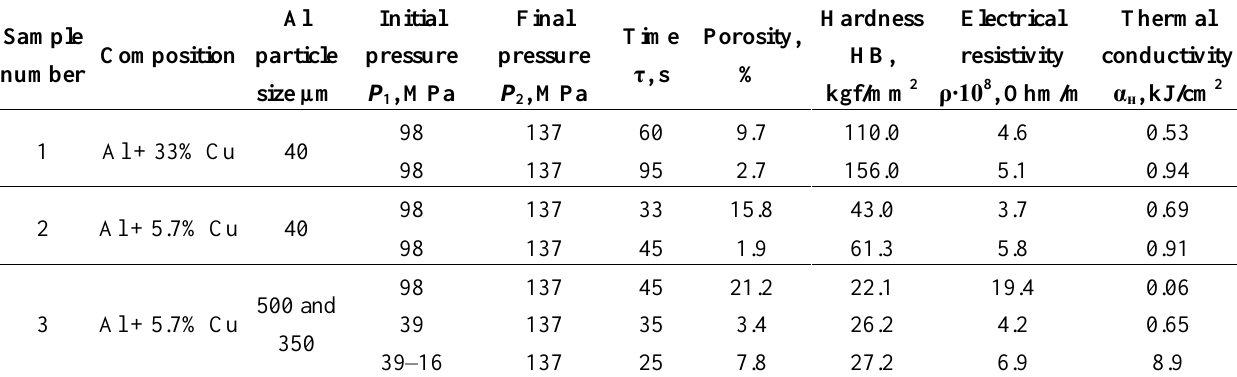
Table 3. Composition, sintering conditions and properties of the sintered